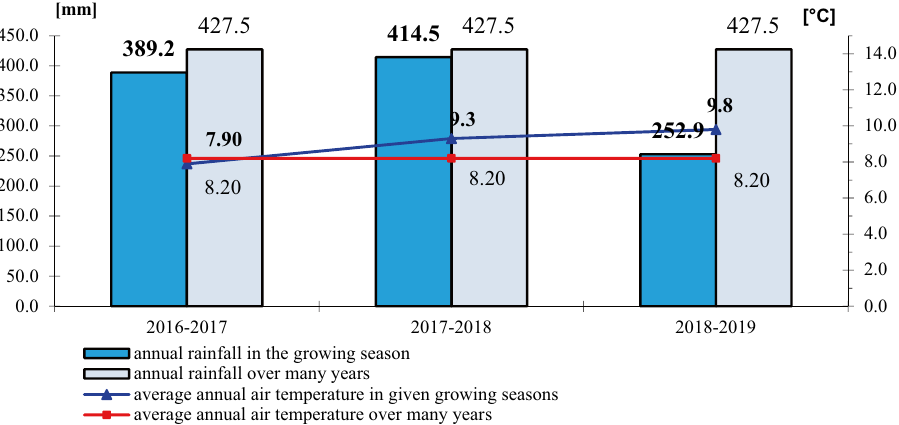
Figure 1. Monthly precipitation sums and average air temperature in given growing seasons RSD Zawady of many years